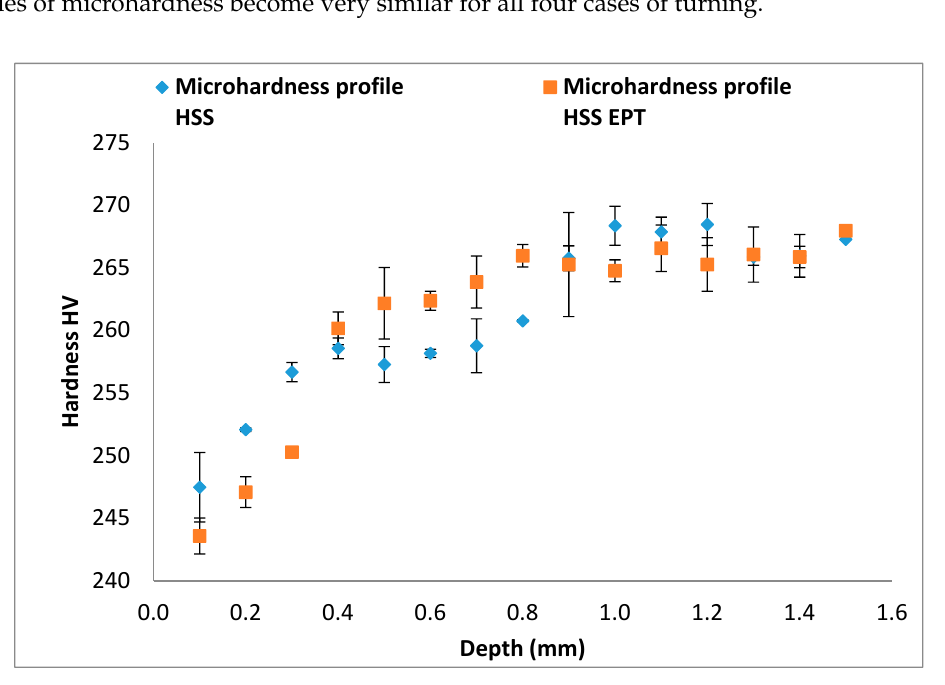
Figure 9. Microhardness profiles of specimens turned with HSS tools.